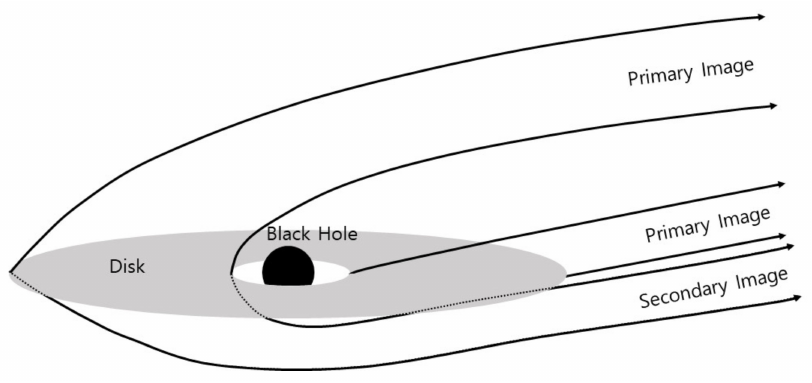
Figure 2. Schematic of the black hole